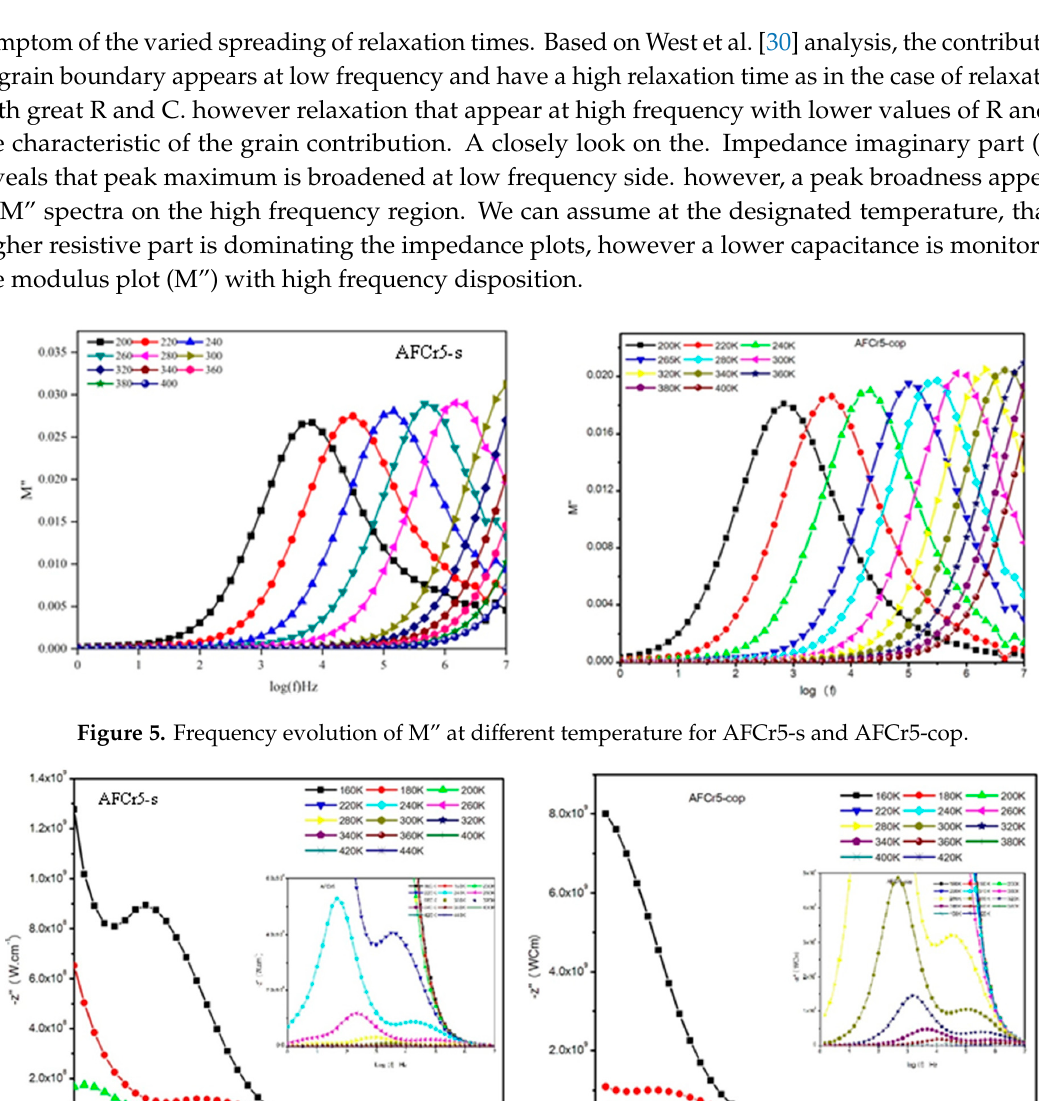
Figure 6. Frequency dependent imaginary part of impedance Z” plot of prepared samples.